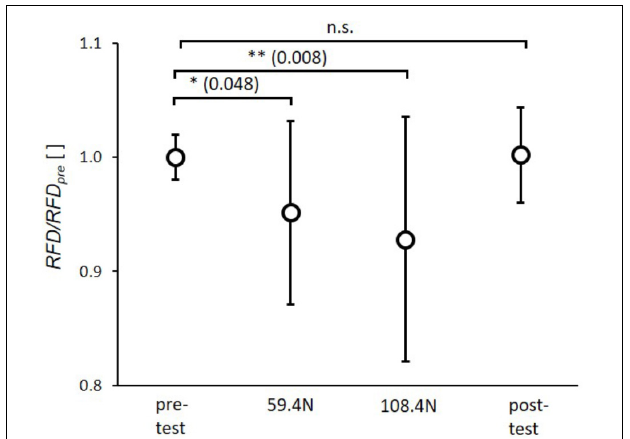
FIGURE 3 | Mean (circles) and standard deviation of rate of force development ( RFD ) for pretest, loading conditions (59.4 and 108.4 N) and post-test. For each subject RFD values of single twitches were normalized by mean subject specific rate of force development of pretest ( RFD pre ).